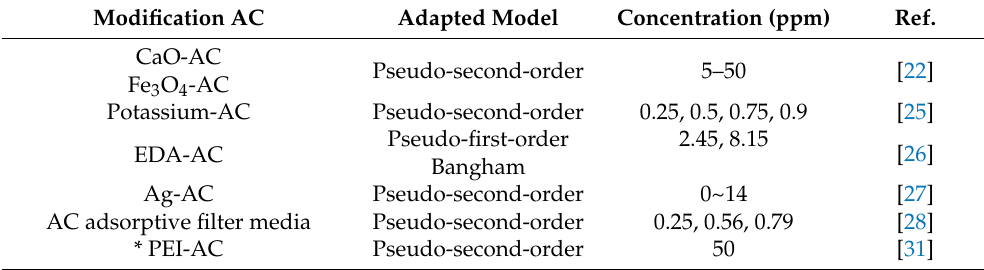
Table 3. Kinetic models for adsorption of formaldehyde on surface-modified AC reported in the